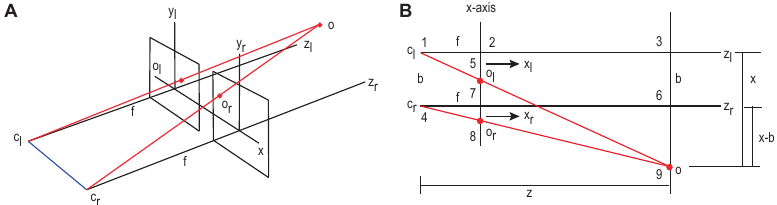
Figure 3. Stereo system setup showing the stereo camera setup in ( A ) and a bird’s eye view of stereo system in ( B